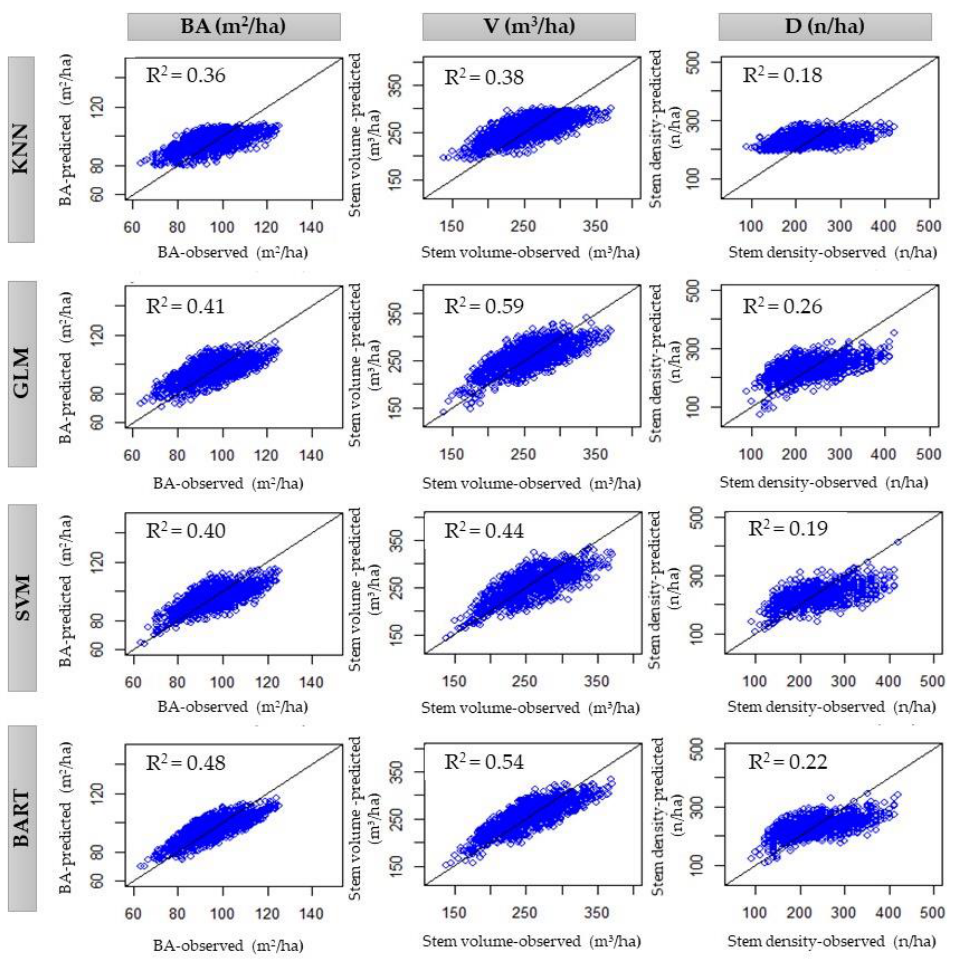
Figure 3. Scatterplots for the predicted vs observed values of basal area, volume, and density by 10-fold cross validation of BART, GLM, KNN, and SVM.